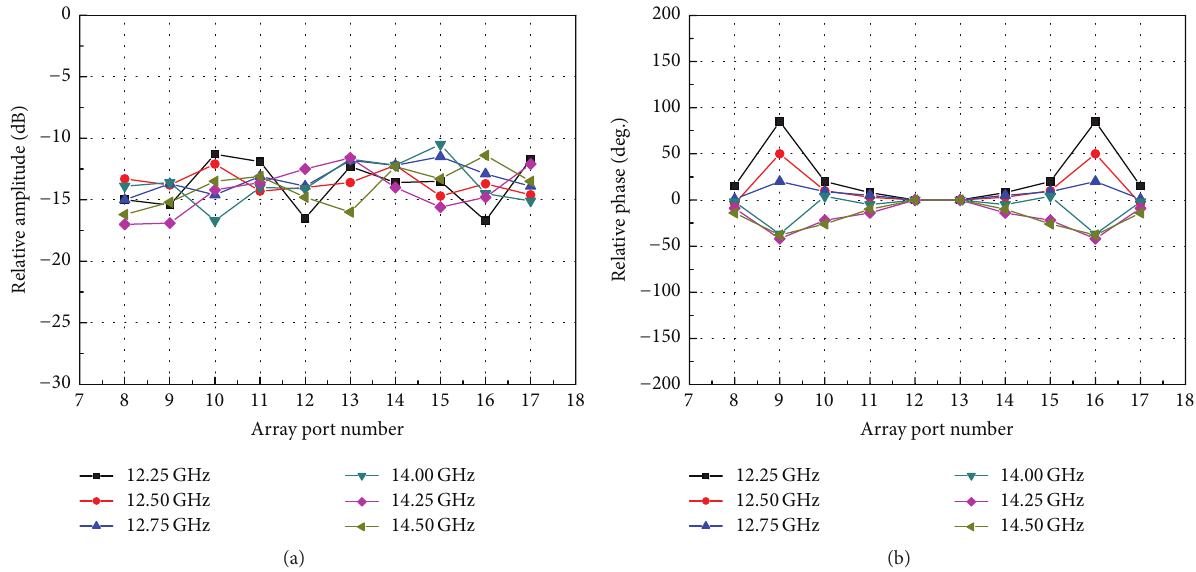
Figure 10: (a) Array ports relative amplitude distribution excited by center port 4. (b) Array ports relative phase distribution excited by center port 4.